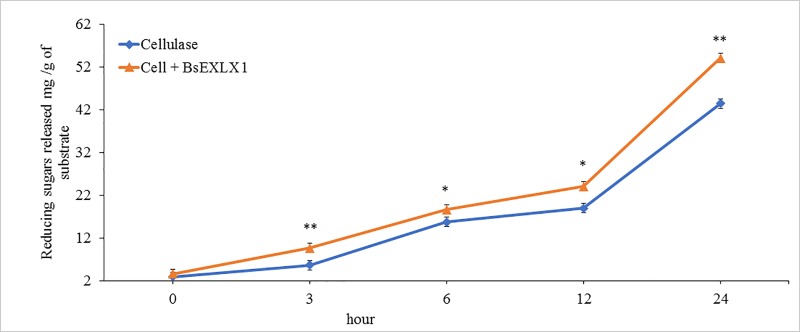
Synergistic effects of cellulase and bacterial expansin-like protein (BsEXLX1; μg/g) on filter paper (# 1) hydrolysis under simulated ruminal conditions of dairy cows (pH 6.0, 39°C, N = 4).Symbol * represents a tendency (P = 0.09) and ** indicates differences between treatments at the same incubation duration (Cellulase × BsEXLX1 × Hour; P < 0.01). Error bars indicate standard errors of the mean (Experiment 3, N = 4). Reducing sugars (DNS positive materials calculated on a glucose-equivalent basis).